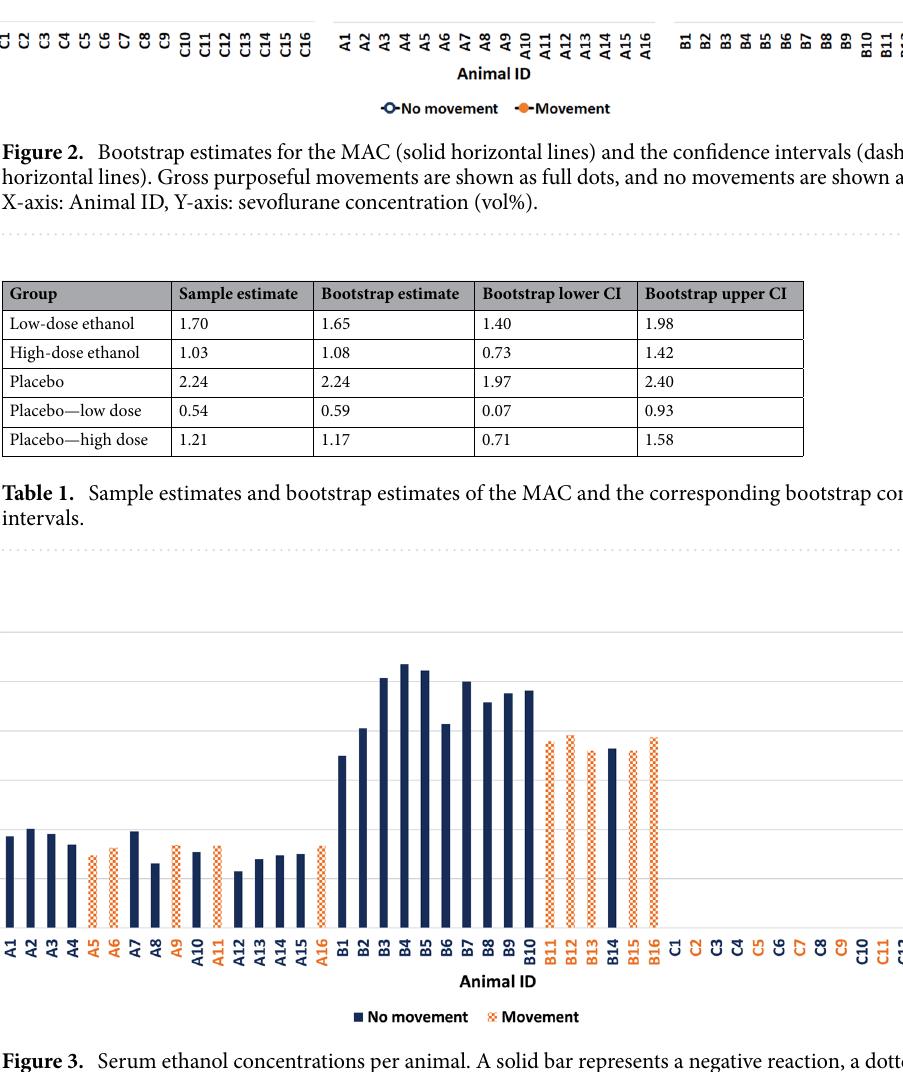
Figure 3. Serum ethanol concentrations per animal. A solid bar represents a negative reaction, a dotted bar a positive reaction. X-axis: Animal ID, Y-axis: Serum ethanol concentrations (mg · dL −1